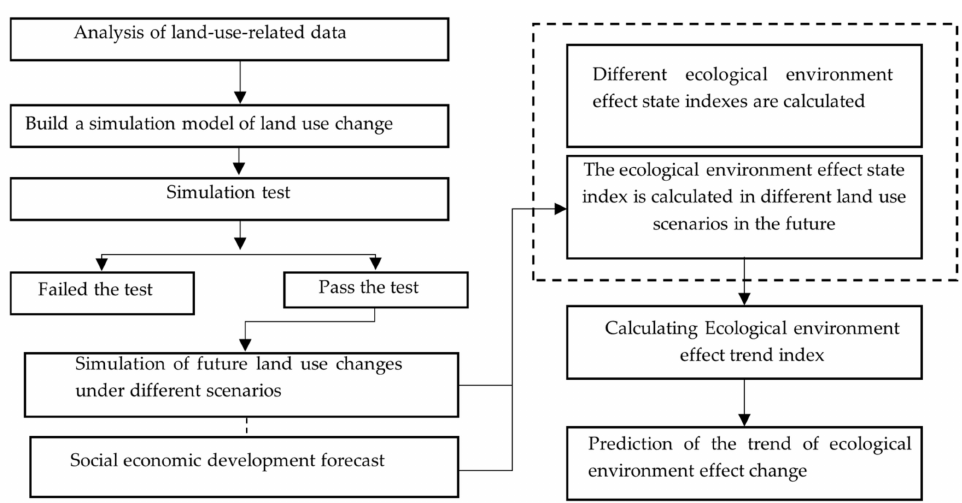
Figure 1. Land-use ecological environmental effect